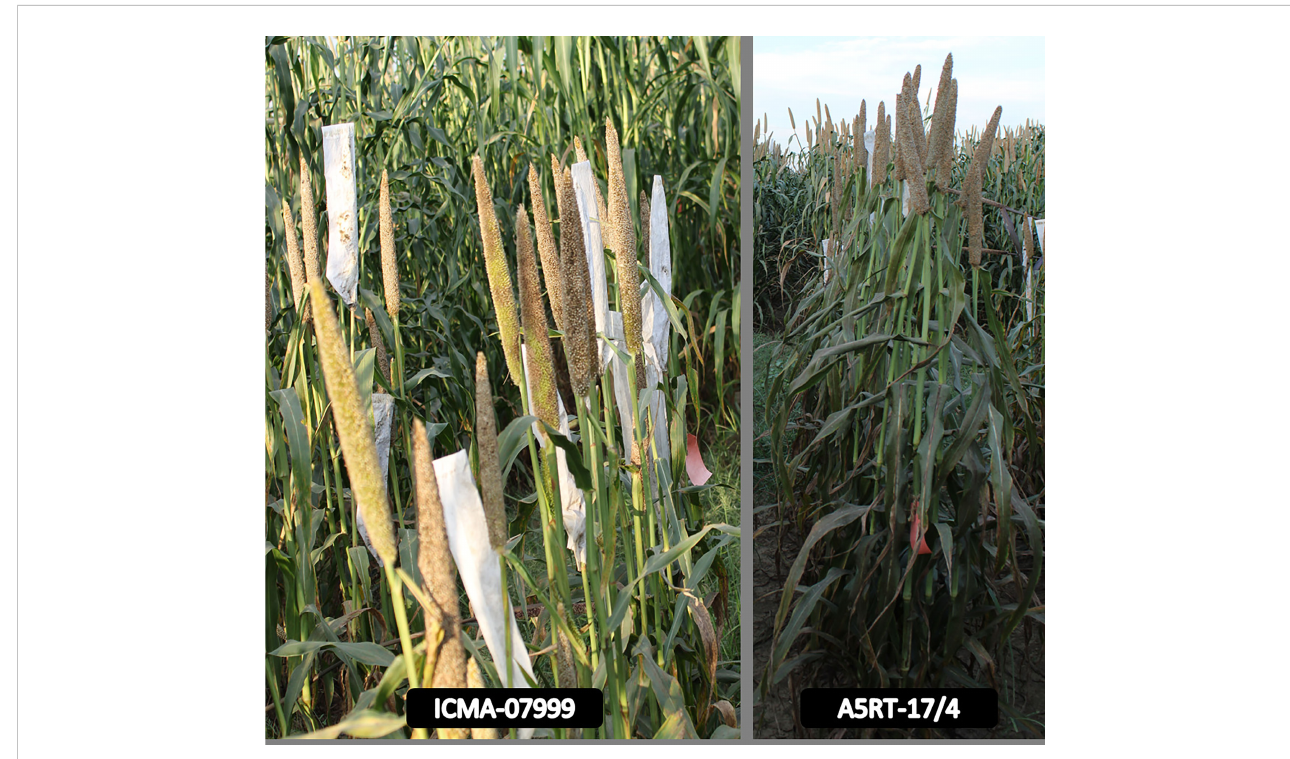
FIGURE 1 Best general combining parents (line and tester) for both grain Fe and Zn